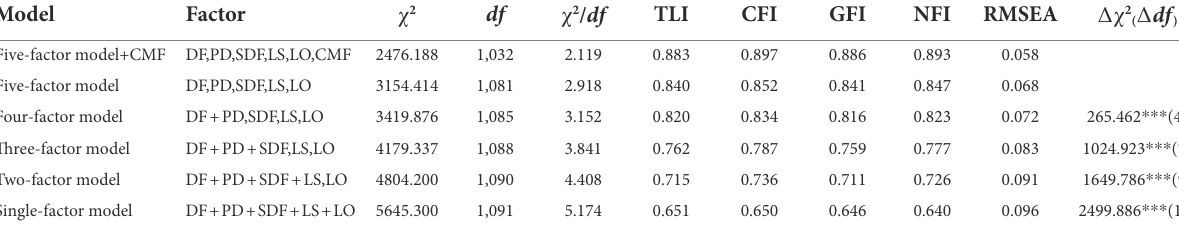
TABLE 1 Discriminant validity